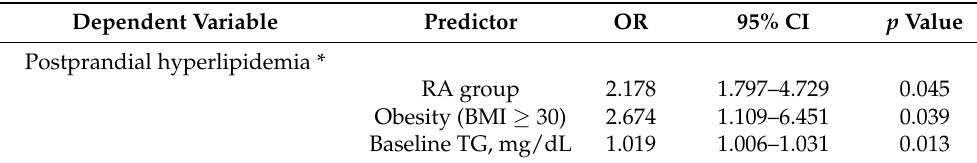
Table 5. Logistic regression model for factors associated with postprandial hyperlipidemia in the whole group. Dependent Variable Predictor OR 95% CI p Value Postprandial hyperlipidemia * RA group 2.178 1.797–4.729 0.045 Obesity (BMI ≥ 30) 2.674 1.109–6.451 0.039 Baseline TG, mg/dL 1.019 1.006–1.031